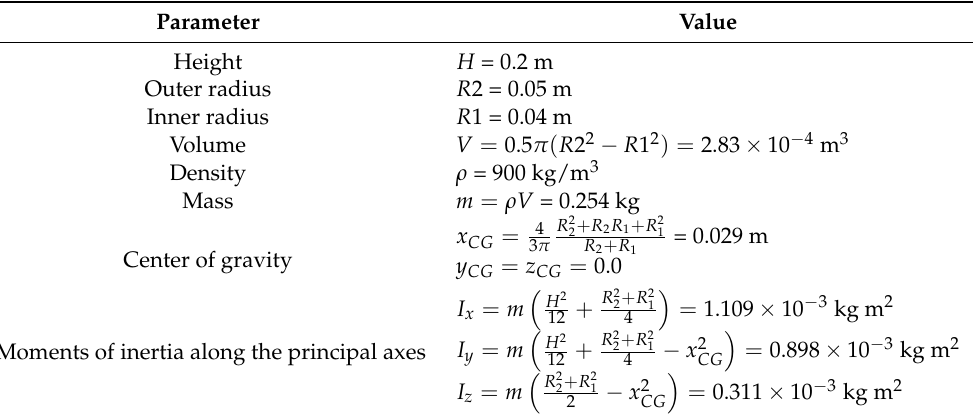
Figure 8. Sketch of the idealised ice chunk shape. Table 2. Main parameters of the idealised ice